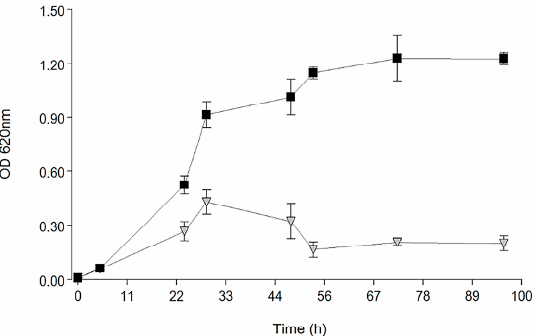
Figure 1. Growth curve for P. syringae Q in the presence of TEO. EO ( ▼ ): 2.9 mg/mL; C ( ■ ): control. The results are expressed as the mean ± standard error (SEM) of the OD measured at 620 nm. Means with di ff erent le tt ers indicate statistically signi fi cant di ff erences ( p < 0.05). Lowercase le tt ers compare the control (0 mg/mL) and strain treated with TEO. In all cases, signi fi cant di ff erences with respect to the control were determined using the Kruskal–Wallis test ( p ≤ 0.05).